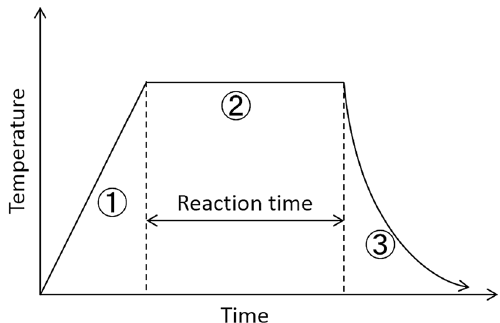
Fig. 1 The growth steps of the Marimo-like carbon. Step 1: Heat- ing-up period. The catalyst was brought into the reactor on a quartz boat, then heated to the appropriate temperatures in the Ar gas flow. The rate of temperature rise was 20 K/min. Step 2: Cata- lytic reaction period. The Ar gas was changed to methane for the Marimo-like carbon growth. Step 3: A period of rest is required. When the growth process was completed, the heating power sup- ply was turned off, and the methane gas flow was converted to the Ar gas flow to cool the grown material to room temperature